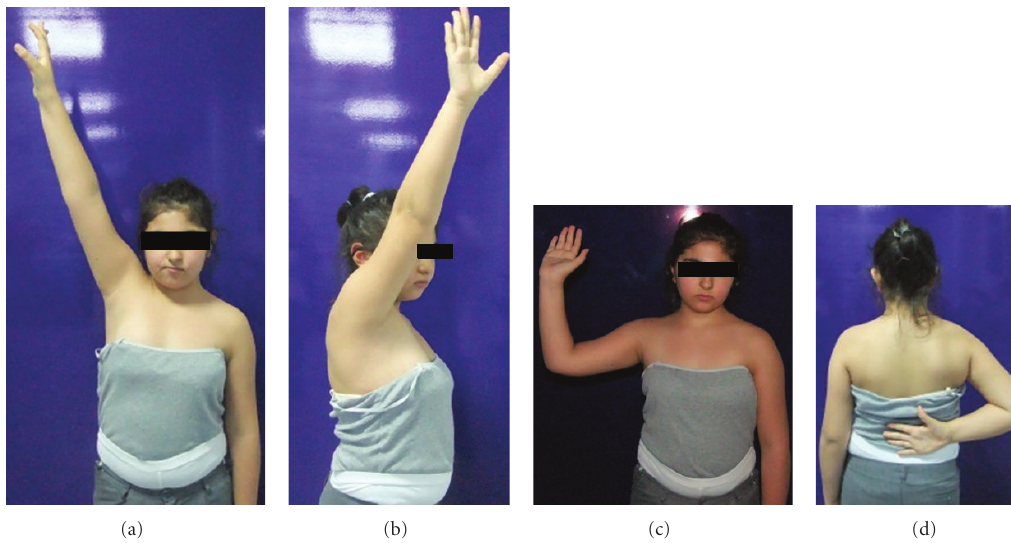
Figure 3: Range of motion and functional clinical views of the